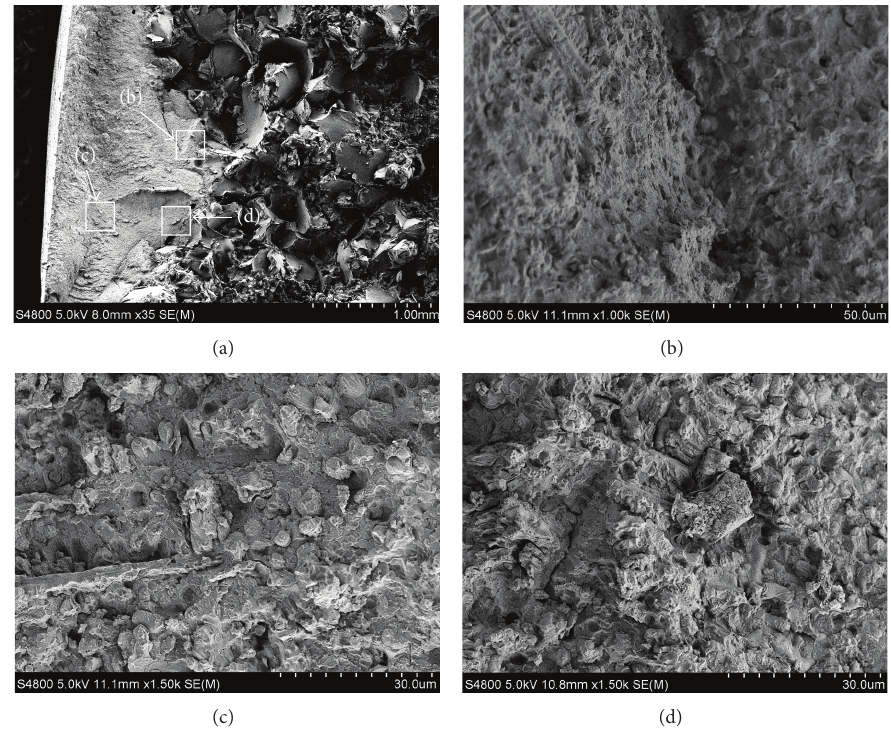
Figure 10: Fracture appearances of Fe314 sample: (a) macroappearance SEM × 35, (b) BZ SEM × 1000, (c) RZ SEM × 1500, and (d) BZ SEM ×